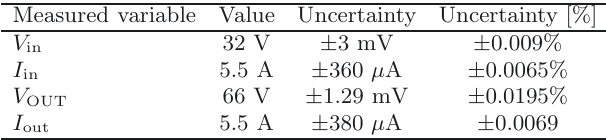
Fig. 13. Current errors bar graph. Table 1. Measurement uncertainty for an individual acquisi- tion card.